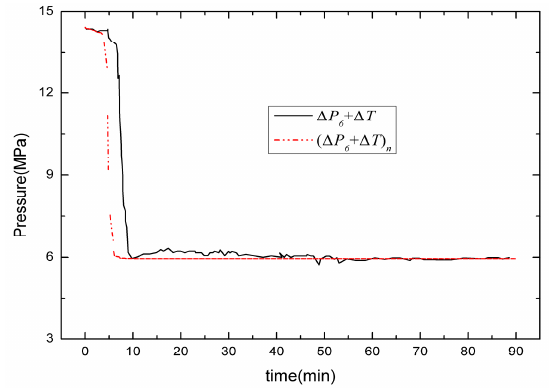
Figure 4. Simulation and experimental comparison of pressure variations during the hydrate dissociation of Δ P 6 + Δ T in the production period.